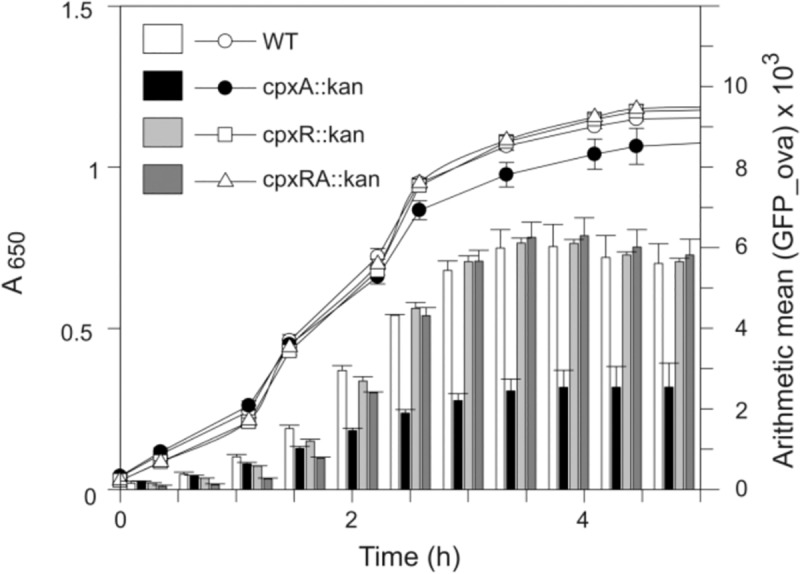
CpxR activity is responsible for hilA transcription.Fluorescence was determined for the SL1344 wild type (white symbols), cpxA (black symbols), cpxR (silver symbols) or cpxRA (dark gray symbols) strains transformed with a plasmid carrying a GFP fusion to the hilA promoter (pD.2E) [52]. Shown are the growth curves (circles) and expression results (bares) for cultures grown under invasion inducing conditions. Shown are the means ± S.E.M. of biological triplicates (t-test).